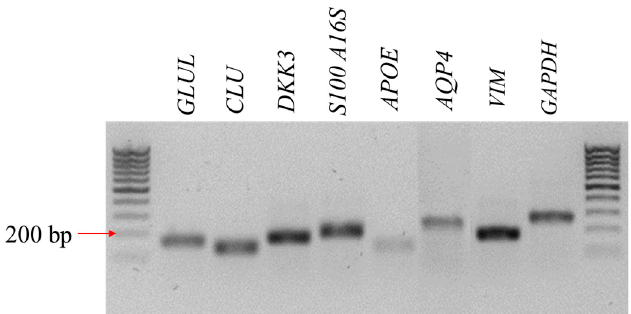
Figure 2. The electropherograms of PCR products identified based on their length (base pair / bp). The CaMLCs expressed specific markers, such as glutamine synthetase ( GLUL ), clusterin ( CLU ), dickkopf homolog 3 ( DKK 3), S100 calcium binding protein A16 (S100A16), apolipoprotein E ( APOE ), aquaporin 4 (AQP4) and vimentin ( VIM ), glyceraldehyde-3-phosphate dehydrogenase ( GAPDH ).